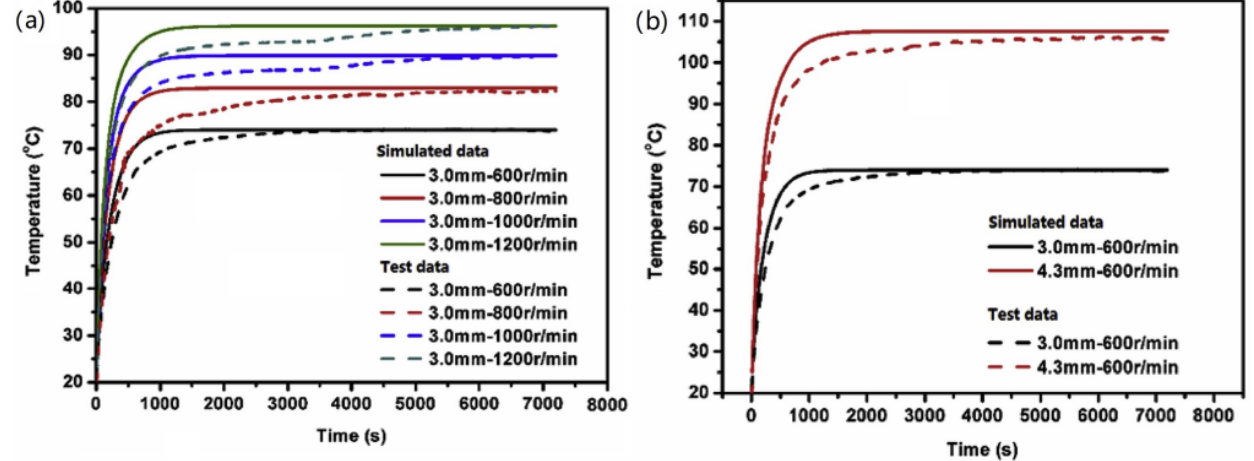
Figure 9. Comparison of temperature–time curves between experimental results and simulation results: ( a ) different rotating speed and ( b ) different compressive displacement [74].